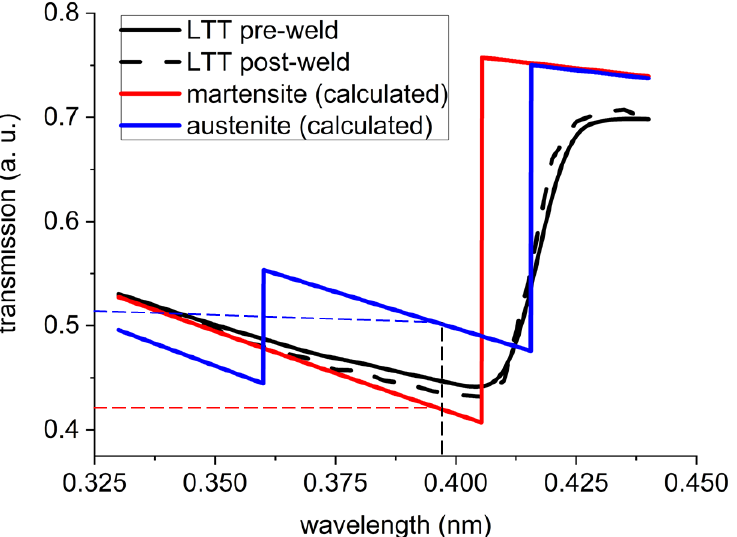
Figure 2. Calculated (colored) and measured (black) Bragg-edge curves for martensite and austenite at room temperature for sample thickness of 5 mm as used in the experiments. The transmission levels at 0.395 nm for the two phases are shown as colored dashed lines. The theoretical data were calculated with the help of a program library [13].